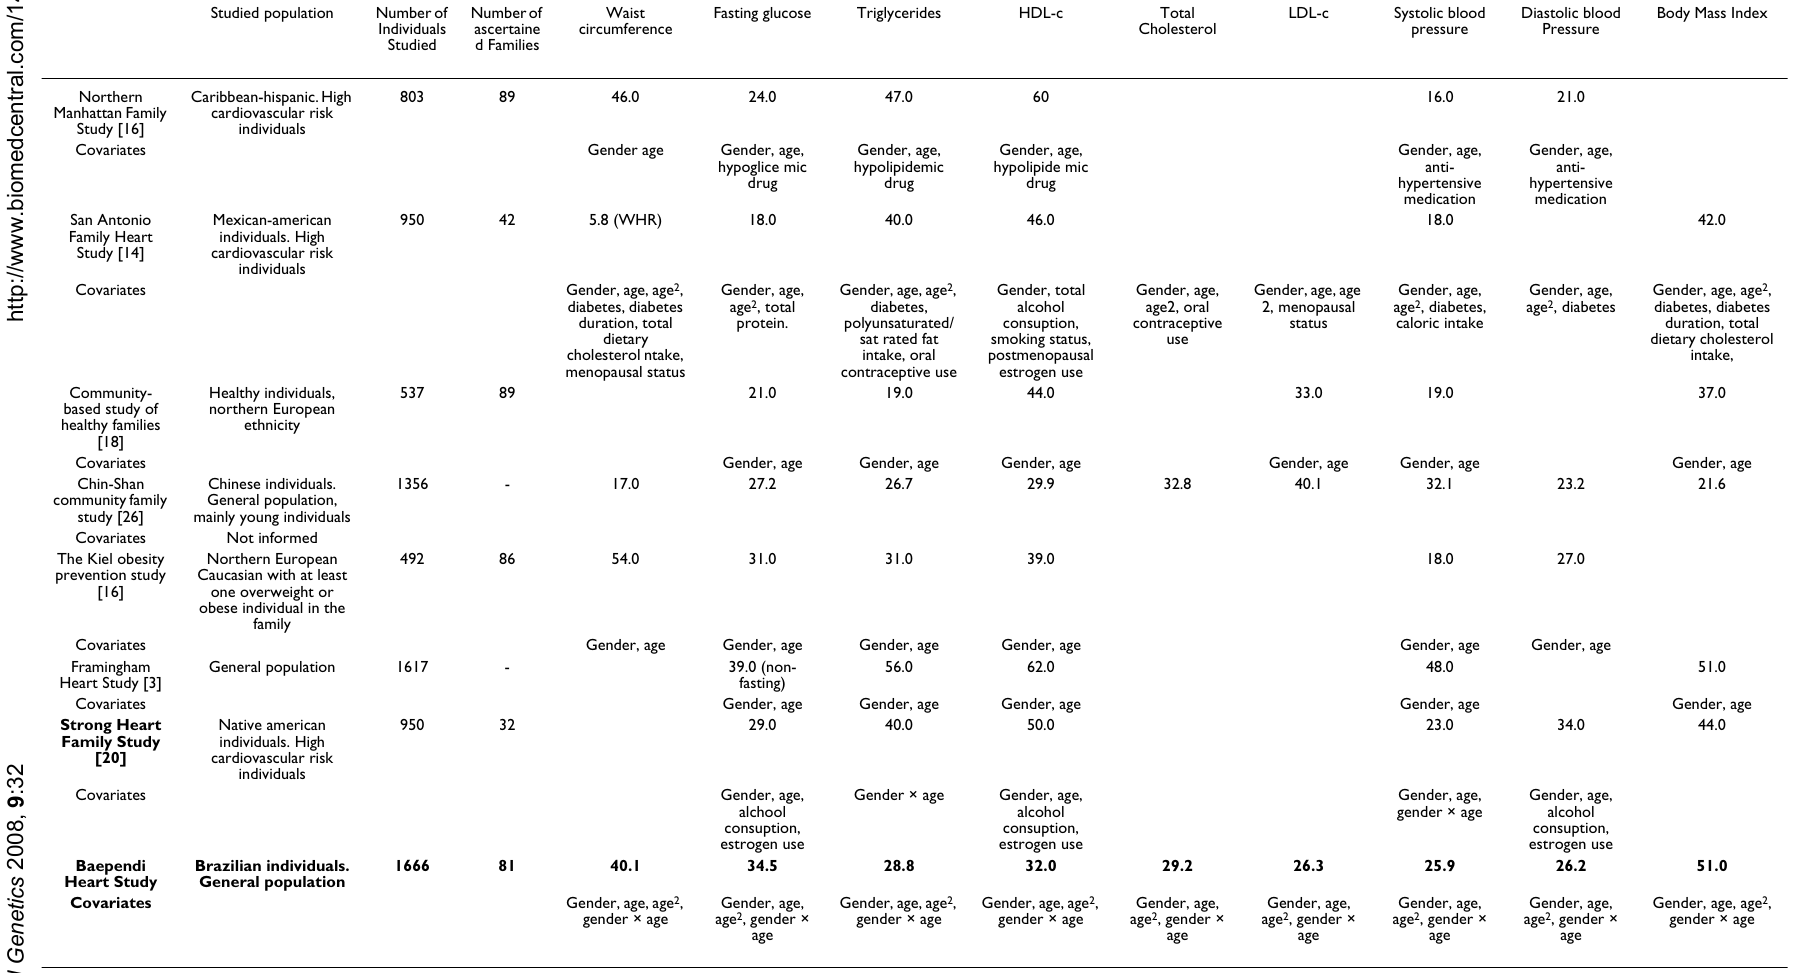
LDL-c Diastolic blood Cholesterol